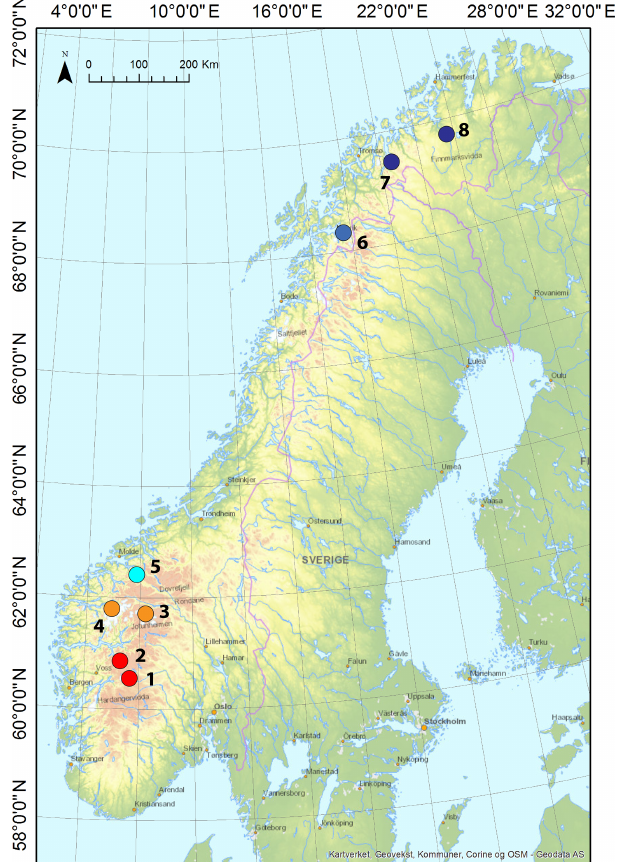
Figure 1. Location of the rock surface temperature loggers in steep rock slopes across Norway. 1. Finse (one logger). 2. Flåm (three loggers). 3. Jotunheimen (four loggers). 4. Loen (three loggers). 5. Mannen (two loggers). 6. Narvik (three loggers). 7. Kåfjord (seven loggers). 8. Alta (two loggers). The colour range is adapted to latitude in accordance with Fig. 2.